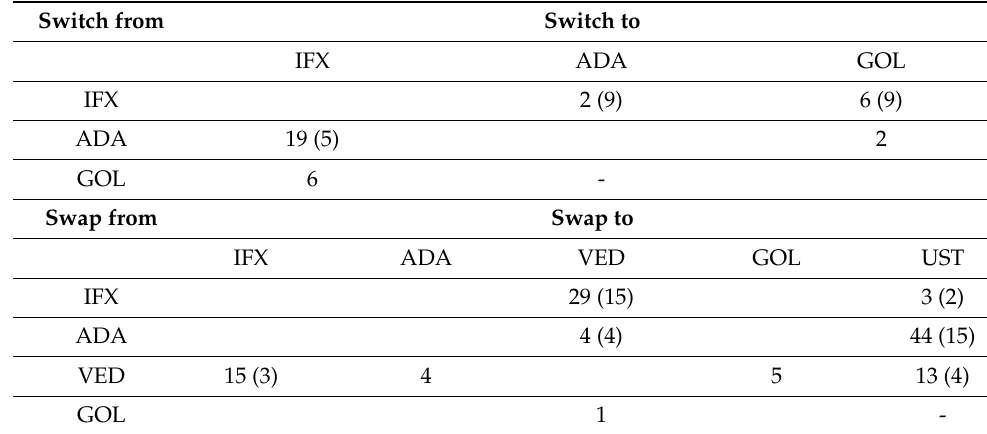
Table 3. Switches and swaps between biologics during the study period.